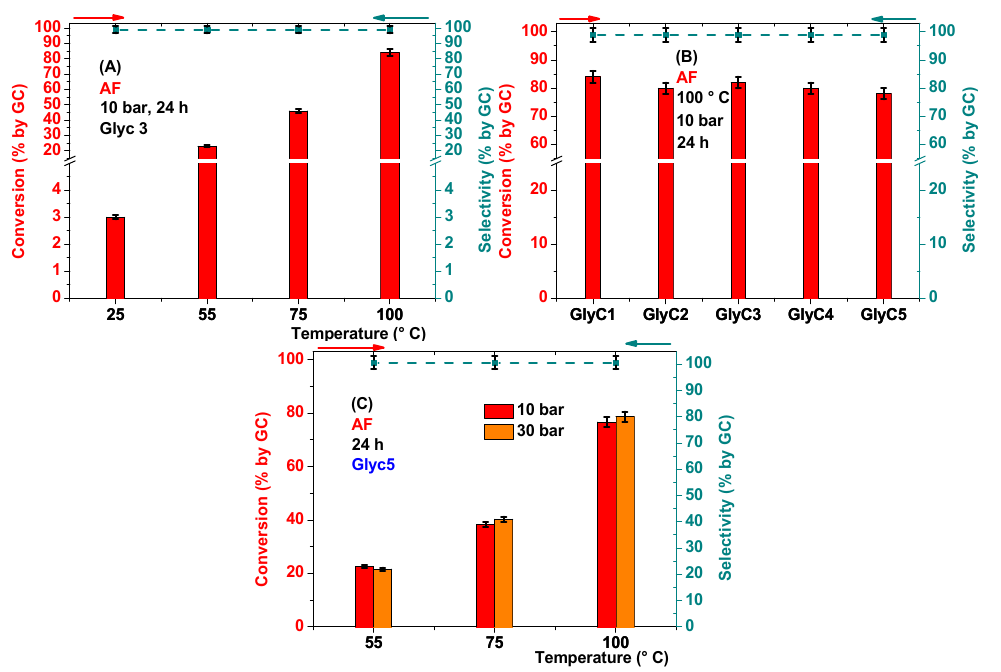
Table 1. Different types of glycerol used in this